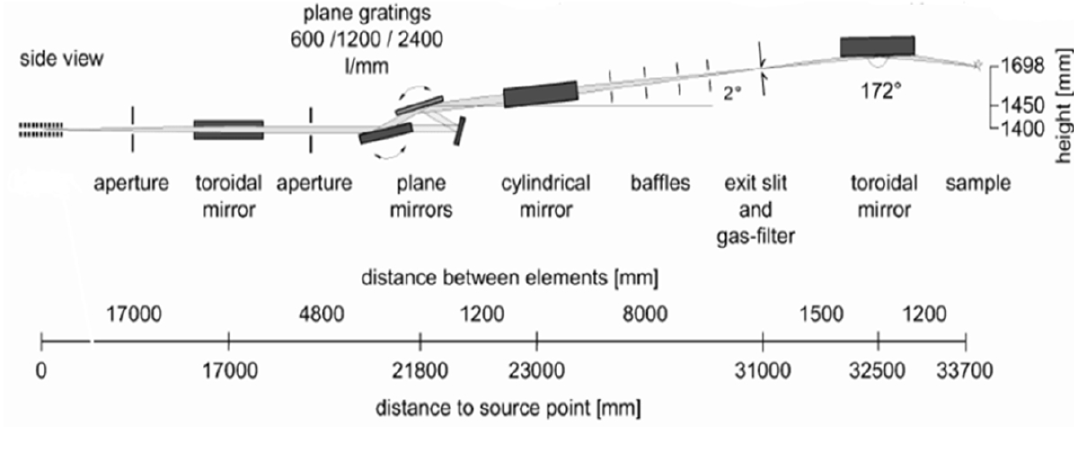
Figure 4: Optical layout of beamline UE112 PGM-2a-12 (by Dr. Rolf